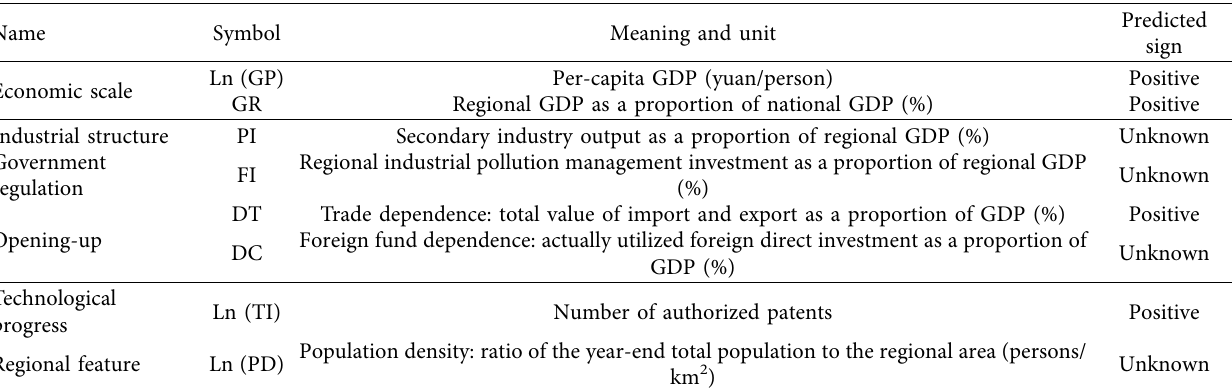
Figure 1: Coefficient of variation for environmental efficiency between cities Table 4: Details about independent variables.